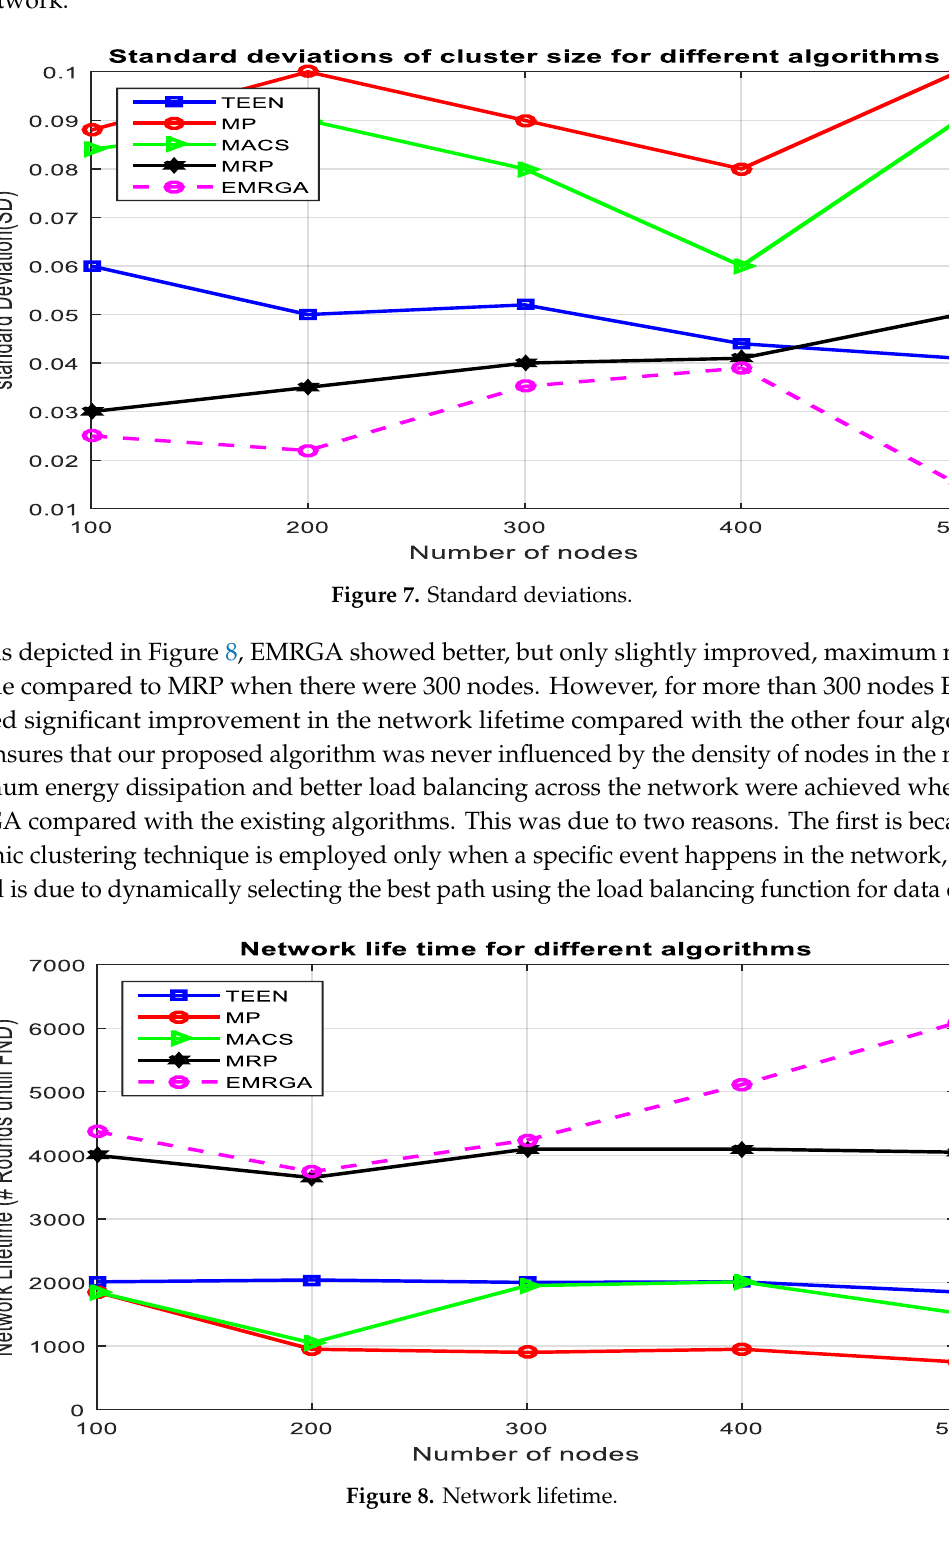
Figure 10. Energy consumption.